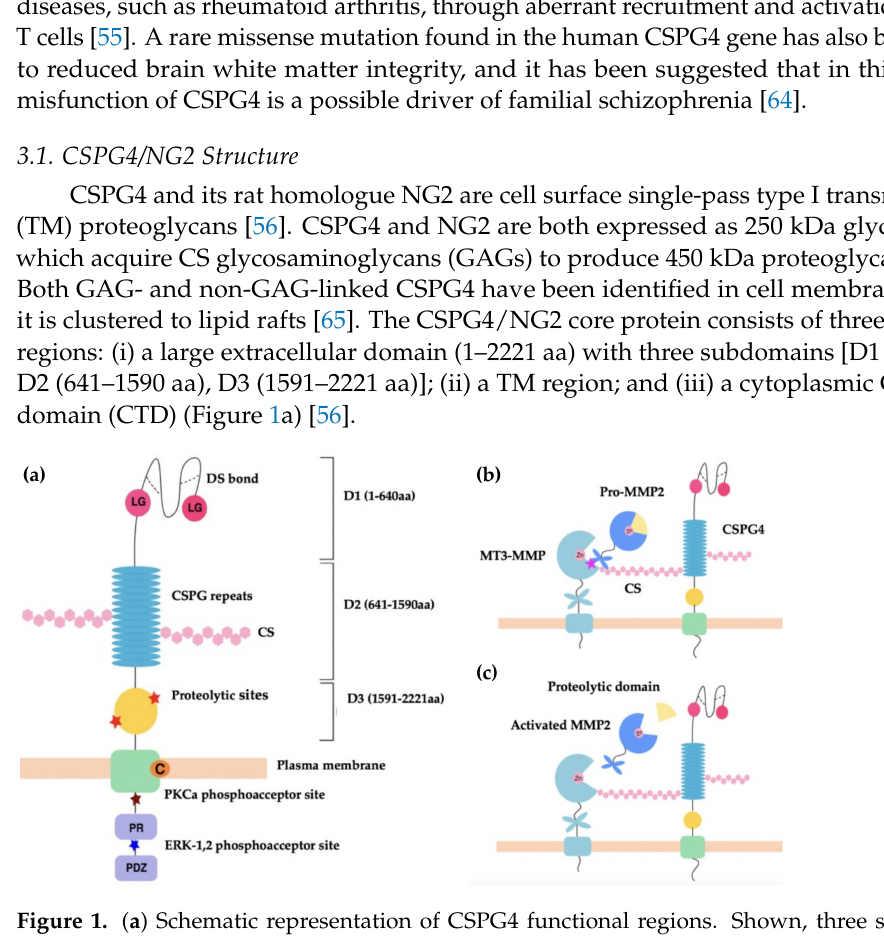
Figure 1. ( a ) Schematic representation of CSPG4 functional regions. Shown, three subdomains of the extracellular region, D1, D2 and D3 of CSPG4/NG2. The D1 structure is maintained by disulfide bonds (dotted lines). The laminin-type globular (LG binding region) in D1 mediates the binding of laminins. D2 contains 15 CSPG repeat sequences and multiple CS binding sites. D3 contains multiple proteolytic sites that are potentially MMP cleavage sites. Intracellularly, the PKC- α phosphoacceptor site is composed of threonine residue Thr 2252 and represents a site of CSPG4 intracellular phosphorylation. The ERK1/2 phosphoacceptor site is also a threonine residue, Thr 2310 . The proline-rich region (PR) is responsible for additional poorly defined protein–protein